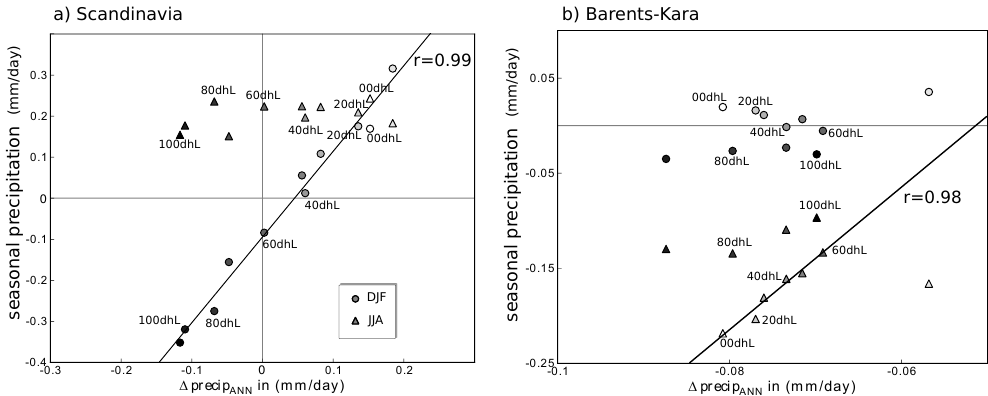
Figure 8. (a) Scandinavian and (b) Barents–Kara precipitation anomalies ( xx dhL-noIS) during winter (circles) and summer (triangles) vs. annual precipitation anomaly. The lower the Laurentide ice-sheet altitude, the lighter grey the symbols